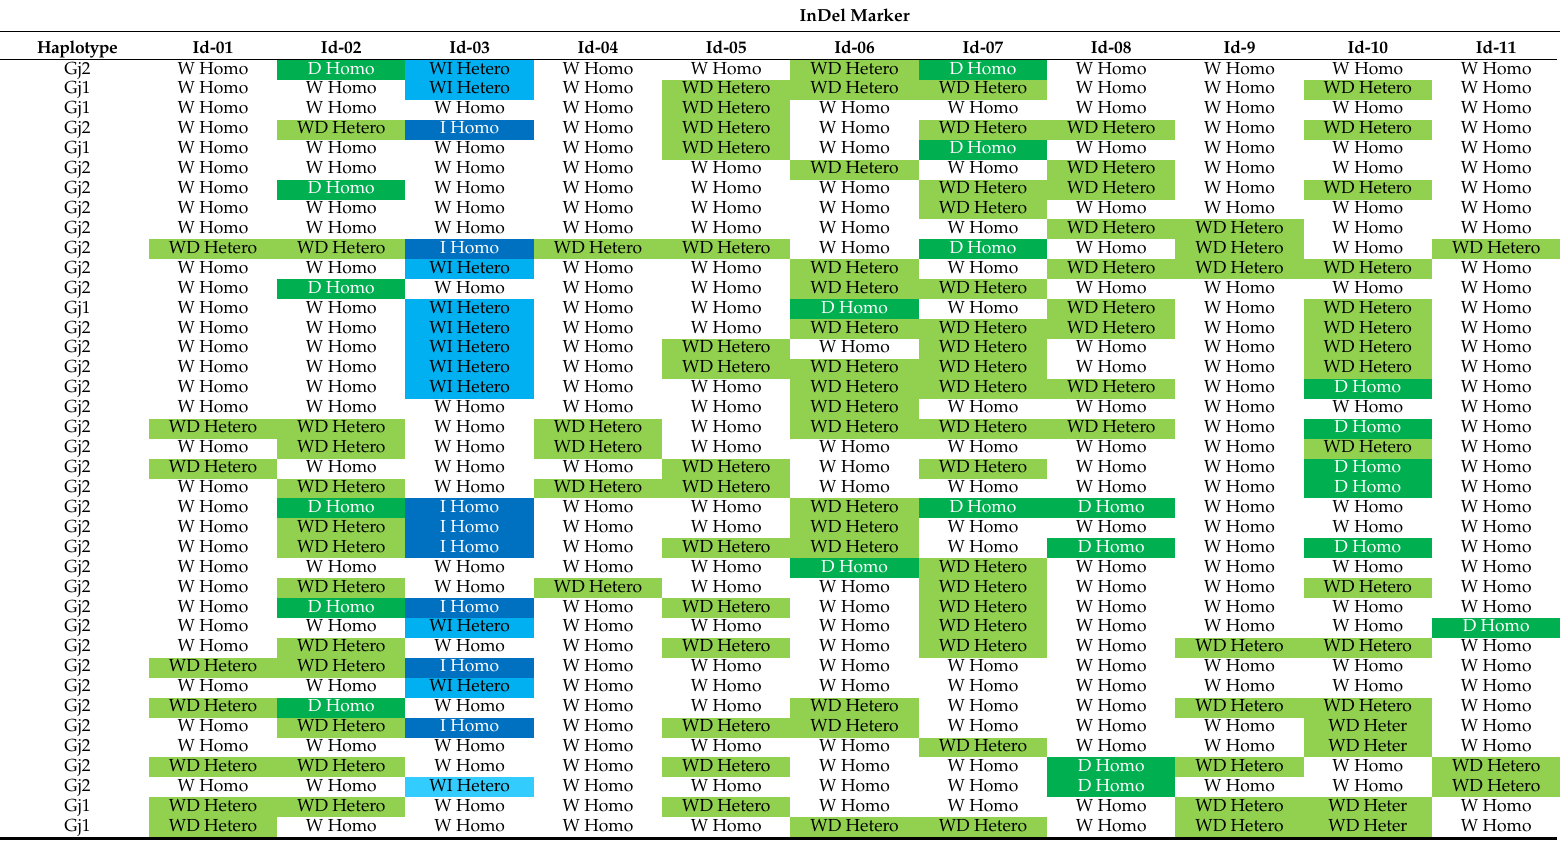
Table 2. Summarized InDel patterns and the other information of non-kin individual red-crowned cranes randomly selected from areas of Kushiro, Nemuro and